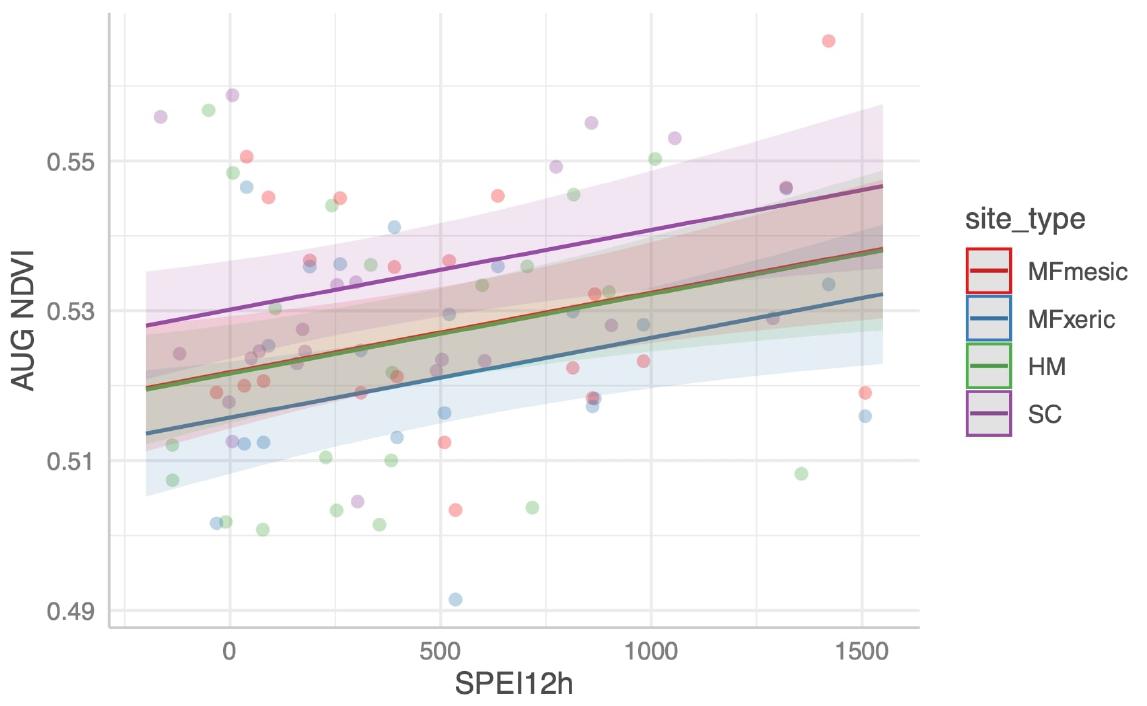
Figure 4. Predicted site average August NDVI for the three sites (MF, HM, and SC) and two subsites (MFmesic and MFxeric).